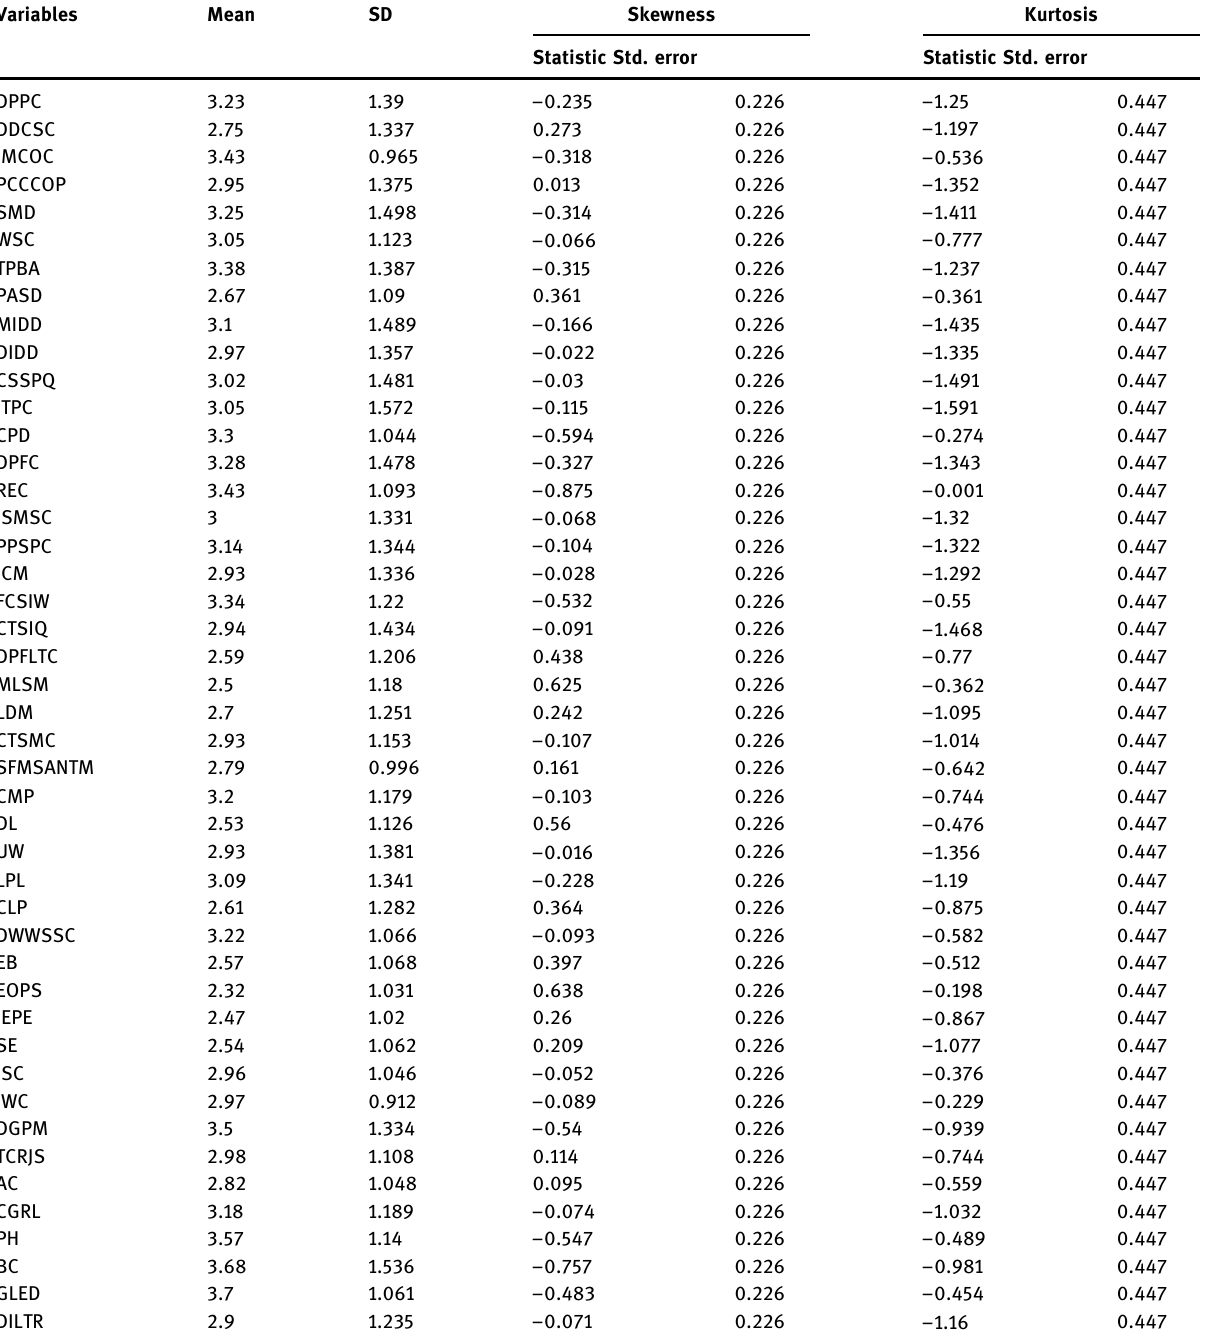
Table 2: Analysis outputs of delay causes of construction projects